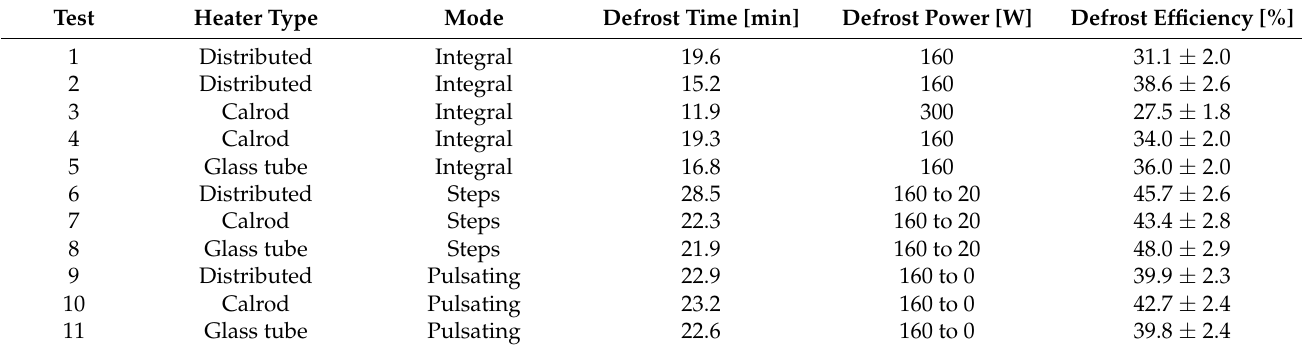
Figure 15. Different actuation modes for defrosting by means of electric heaters [124]. Table 3. Defrost efficiencies comparative (data from Melo et al.